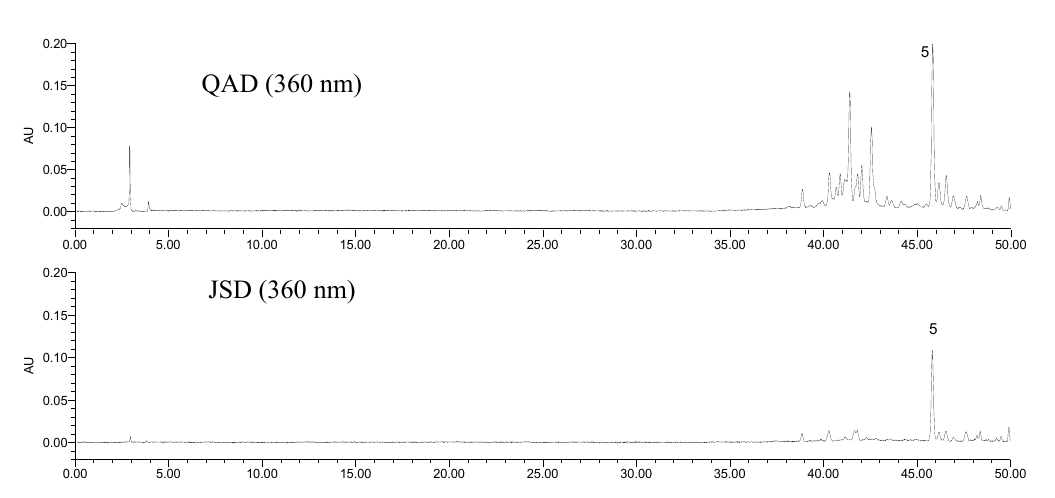
Table 4. Contents of the seven studied compounds in the investigated samples ( n = 3). Sample